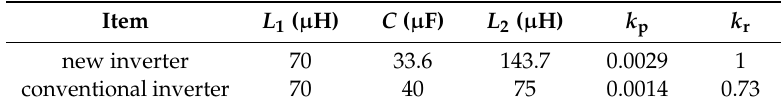
Table 2. New and conventional inverter